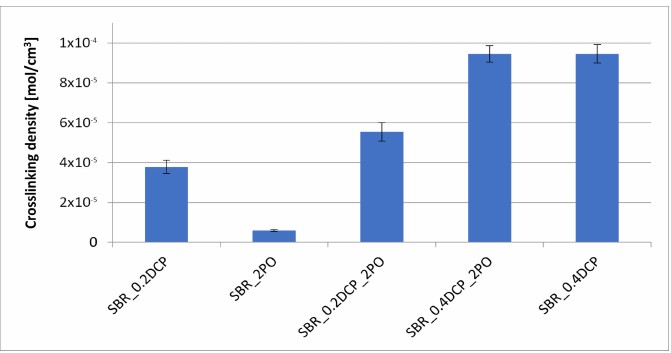
Figure 5. Influence of the modified resin addition on the crosslink density of SBR.